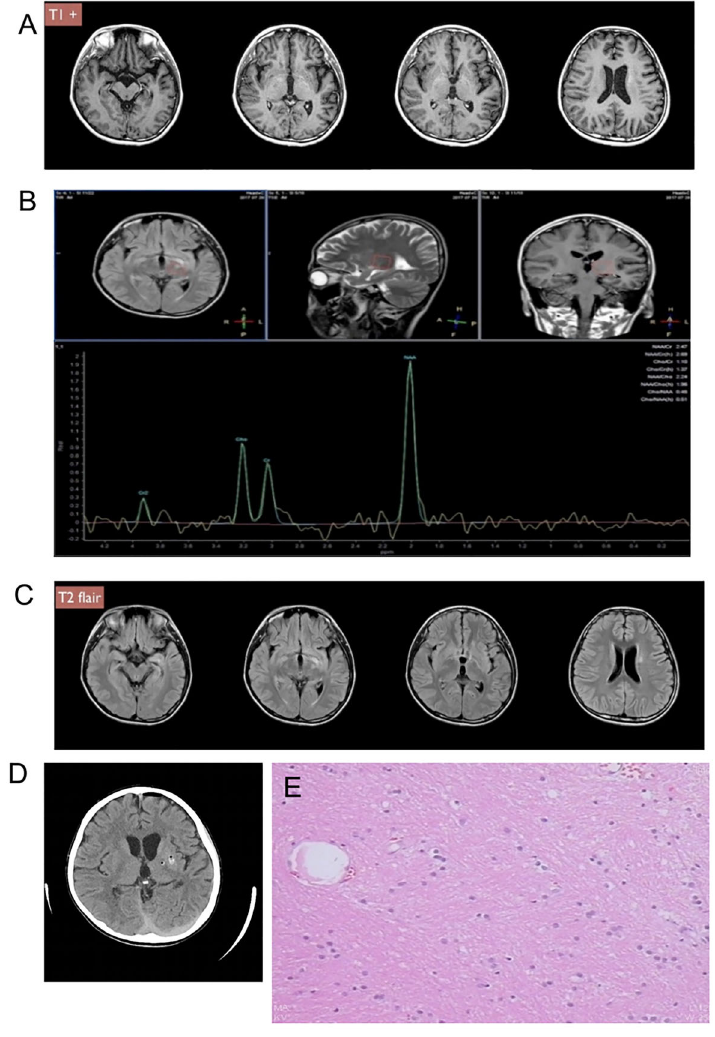
Figure 1. Case 1. A , Preoperative head T1-weighted contrast-enhanced magnetic resonance imaging (MRI) revealed left ventricle dilatation, enlarged sacral angle, and suspicious high signal on the left side of the ventricle, left basal ganglion. B , Magnetic resonance spectroscopy shows left basal ganglion NAA/Ch: 2.24, NAA/Cr: 2.69, Ch/Cr: 1.10. C , Preoperative head MRI T2 fl air showed small abnormalities in the left ventricle, left midbrain, and thalamus. D , Computed tomography scan 2 h after surgery showed left basal ganglion micro-bleeding grade I and small areas of pneumocephalus. E , The pathological fi nding showed a single cell of a germ cell